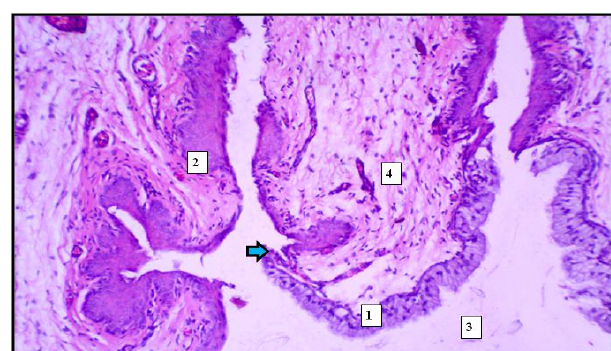
Figure 11. Vagina wall near the vaginal orifice showing changing of the simple columnar mucous (1) into stratified squamous epithelium (2). The figure showed area of junction (blue arrow) and vaginal lumen (3) and propria-submucosa (4). 100X,